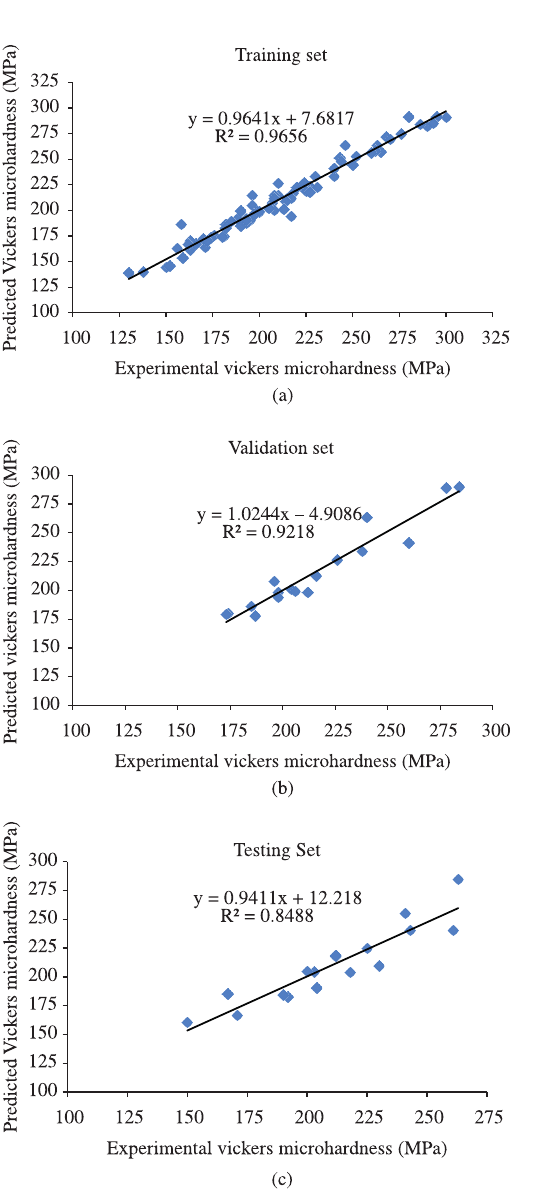
Figure 6. The correlation of the measured and predicted Vickers microhardness values in a) training, b) validation and c) testing sets for ANFIS-I model.